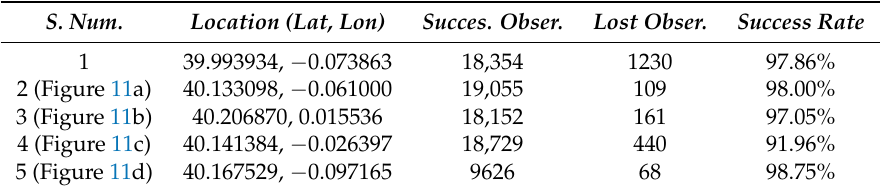
Table 10. List of SEnviro nodes